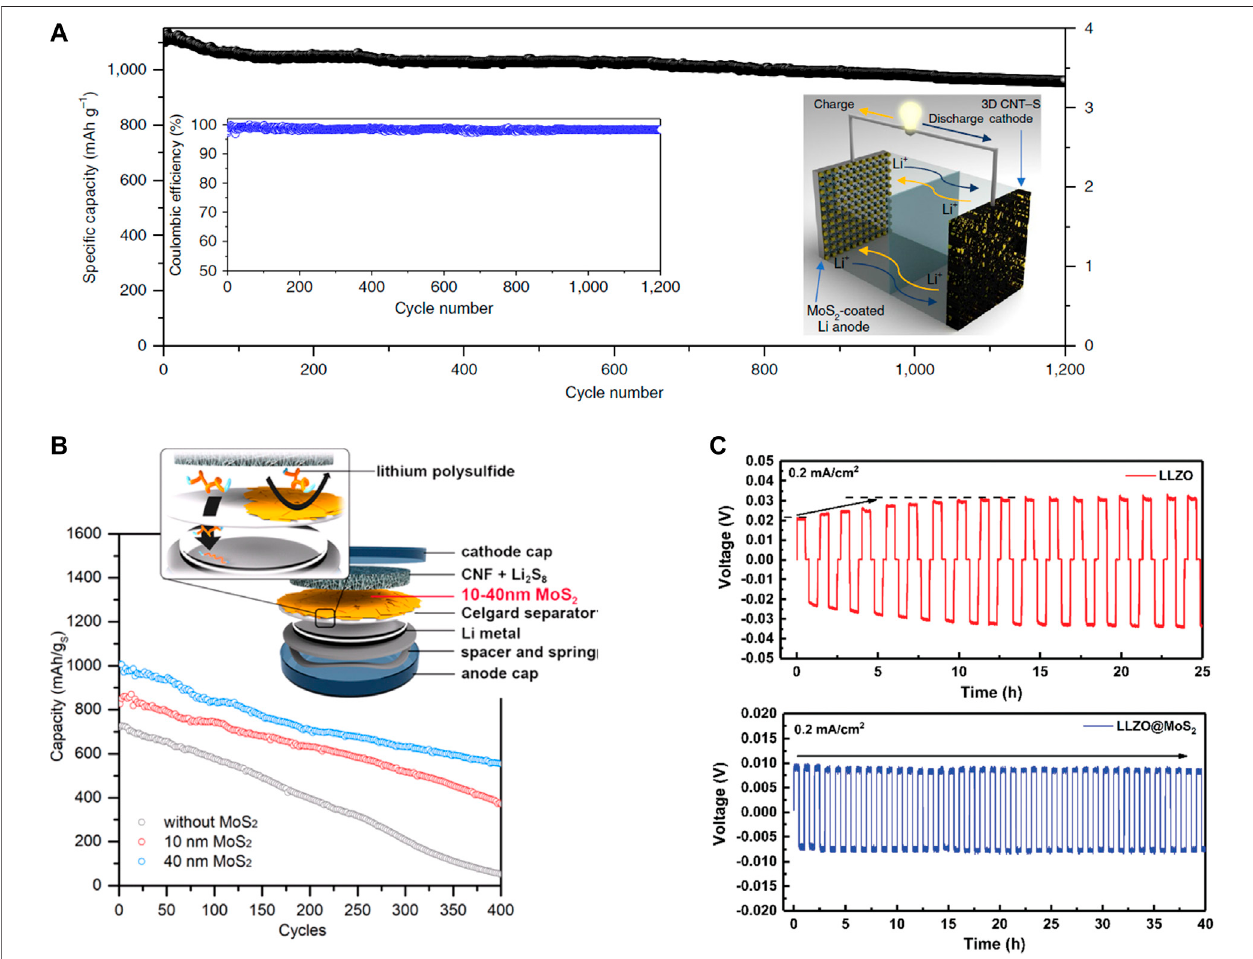
FIGURE 2 | (A) The long-term cycling performance of Li – S battery with the MoS 2 protected Li anode. (B) Schematic depiction of the MoS 2 modi fi ed Celgard separator and its application for Li – S batteries. (C) The voltage pro fi les of the symmetric cells using either the pristine (red) or the MoS 2 coated LLZO pellets (blue). (A) Reproduced with permission. Cha et al. (2018) Copyright 2018, Springer Nature. (B) Reproduced with permission. Yu et al. (2019) Copyright 2018, American Chemical Society. (C) Reproduced with permission. Fu et al. (2019) Copyright 2019, Royal Society of Chemistry.